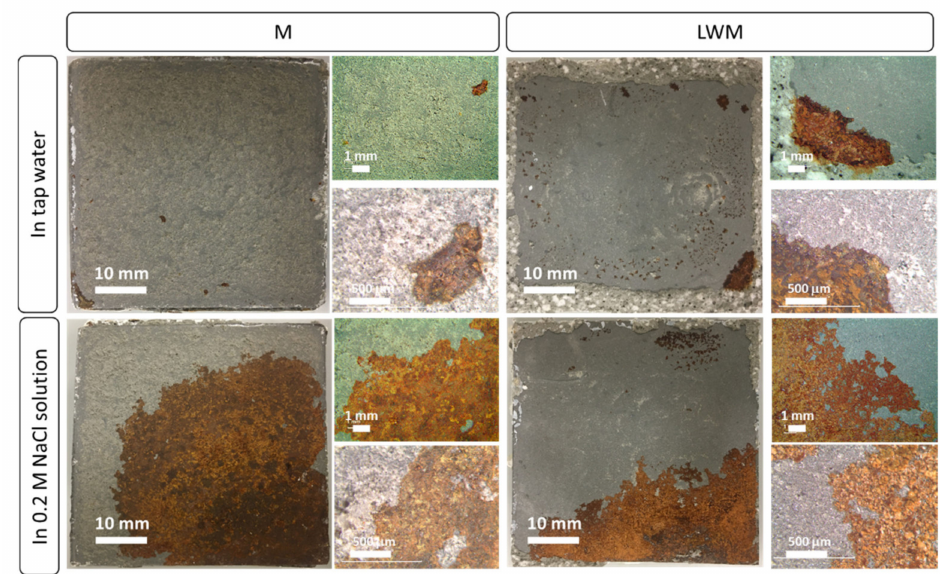
Figure 6. Macro and low magnification images of the carbon steel plates coated with 20 mm thick M or LWM layers after 60 days of immersion in tap water and in 0.2 M NaCl aqueous